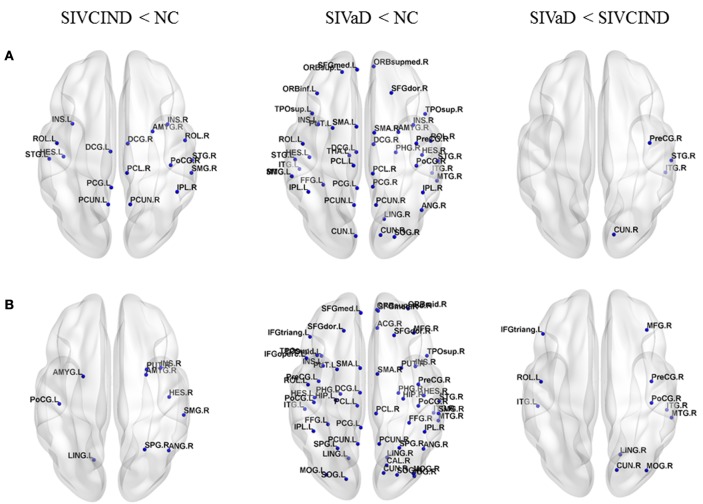
Brain regions showing significant differences in nodal efficiency among SIVCIND, SIVaD, and normal controls. The results were visualized using BrainNet Viewer (NKLCNL, Beijing Normal University). Three-dimensional maps show significant differences in (A) nodal global efficiency and (B) nodal local efficiency among SIVCIND, SIVaD, and normal controls. Detailed brain region information corresponding to the anatomical labels can be found in Table S1 in Supplementary Material.